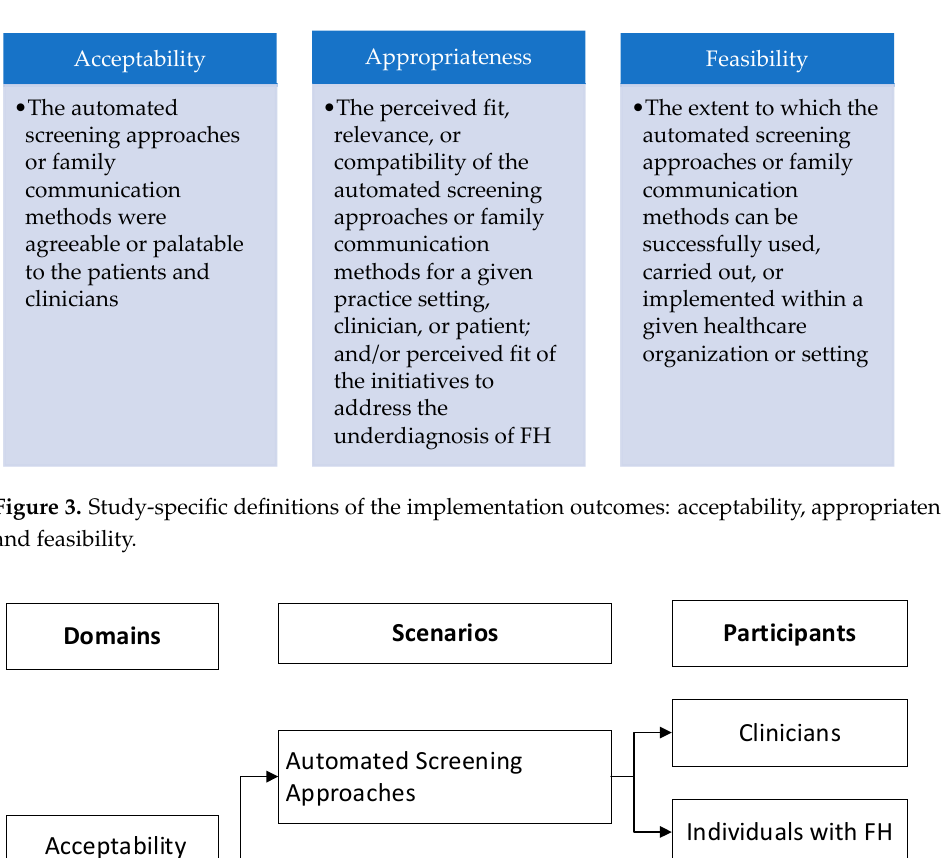
Table 2. Demographics of individuals with FH and clinicians.